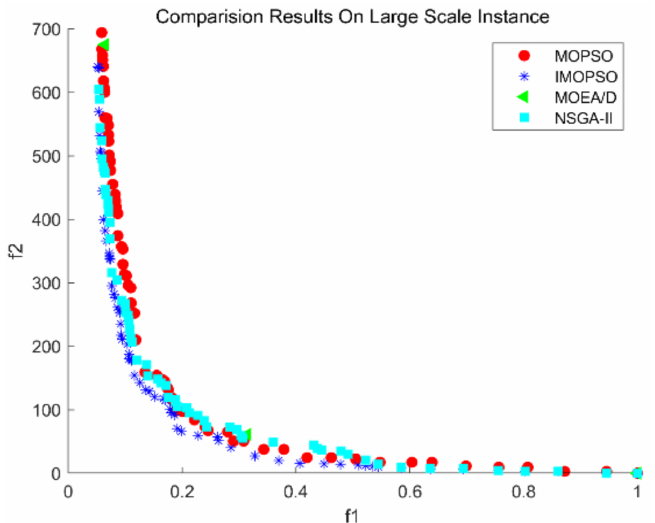
Figure 18. Comparison of four algorithms on large-scaled